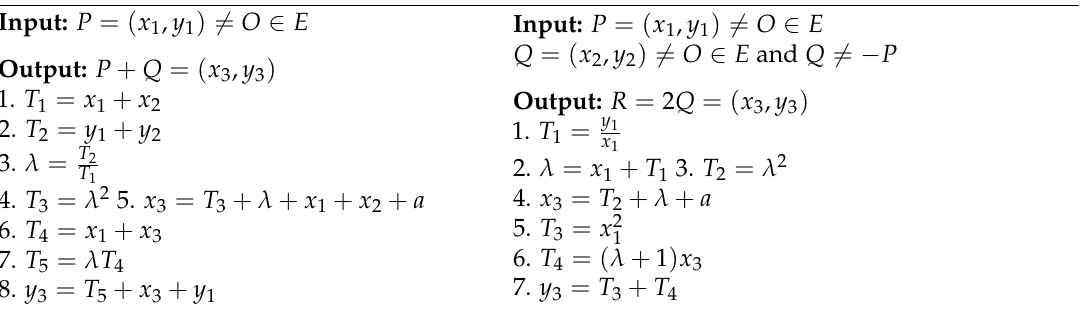
Algorithm 1 : Point Addition and Point Doubling.